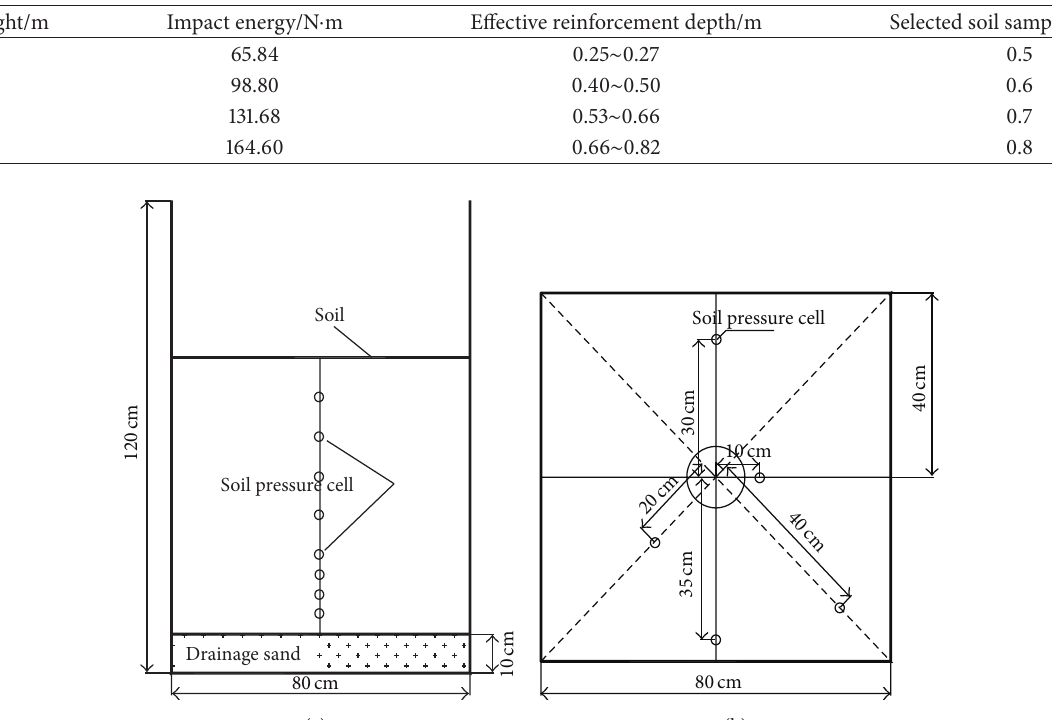
Figure 2: Layout of earth pressure boxes at a drop height of 0.8 m: (a) in the vertical direction; (b) in the horizontal direction.